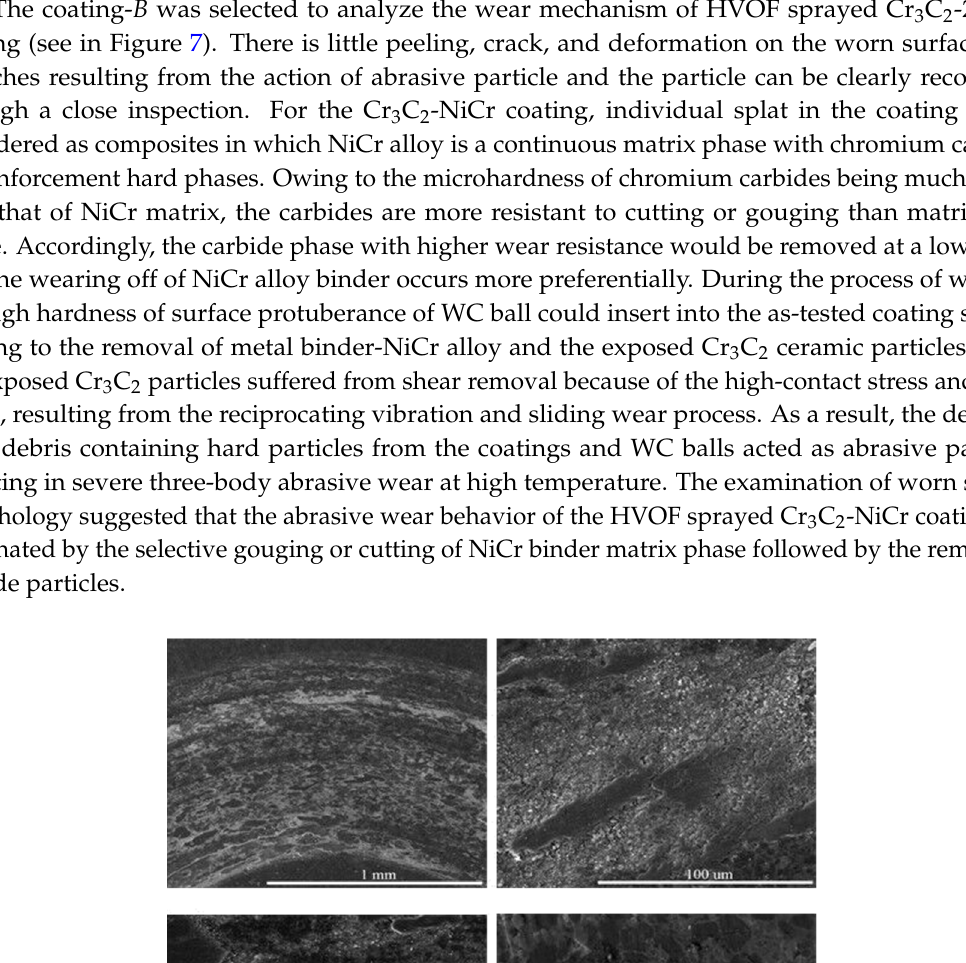
Table 3. The wear rates of the coatings.